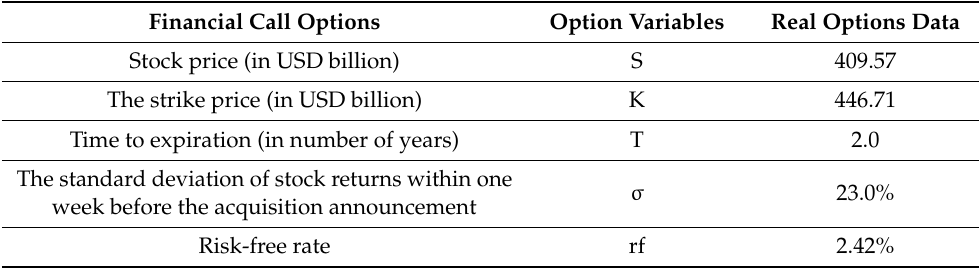
Table 3. The parameters of real options pricing model’s input variables: Amazon.com’s acquisition of